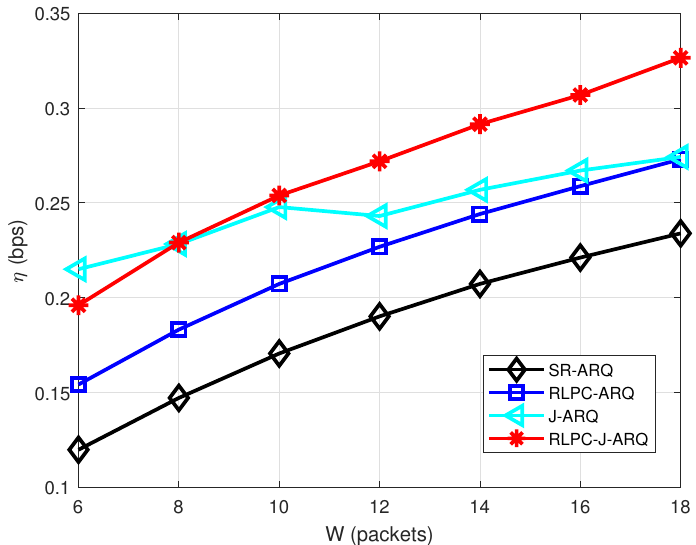
Figure 4. Throughput efficiency as a function of the number of group packets W .